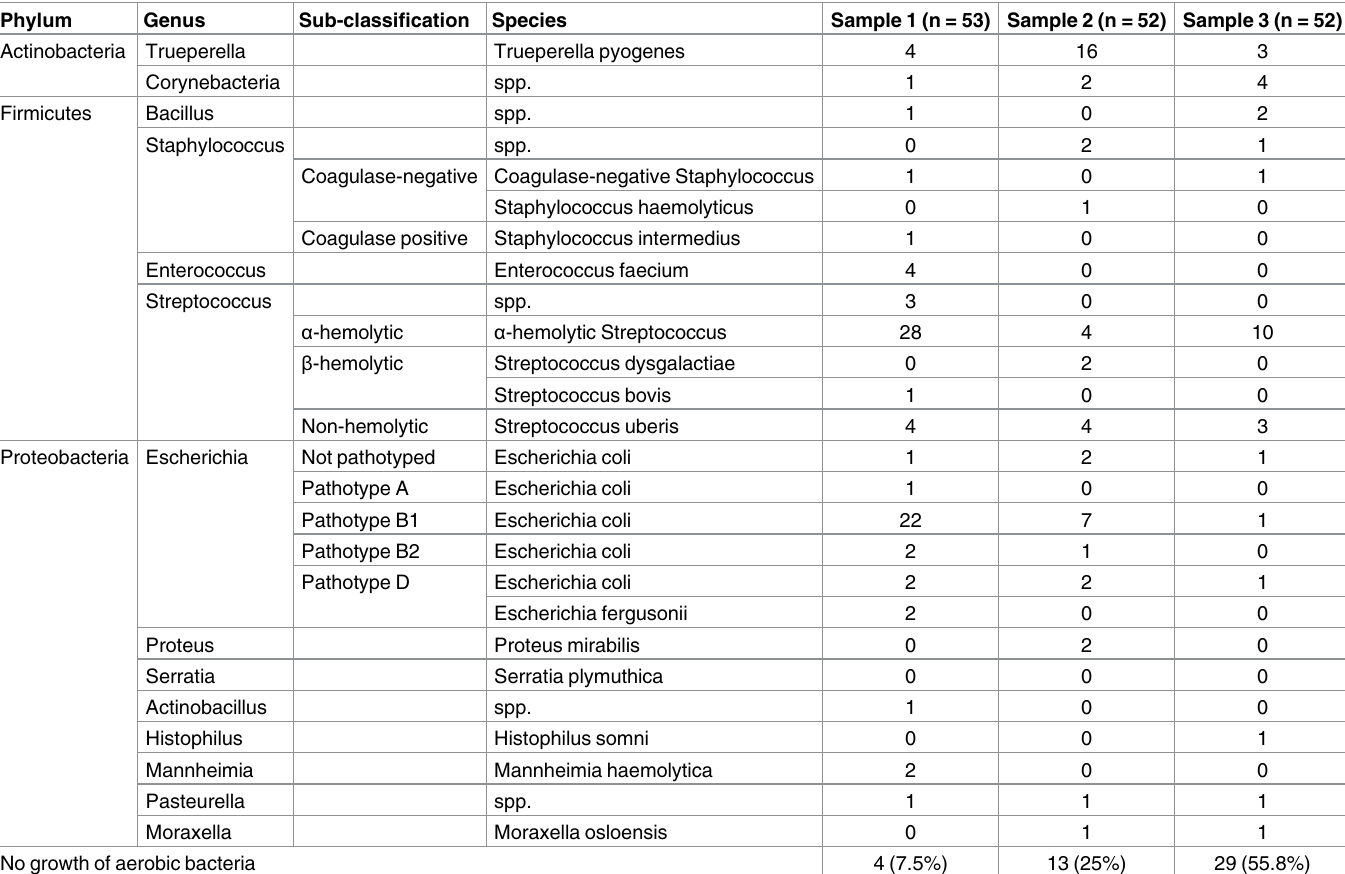
Table 1. Number of samples that cultured positive for each type of aerobic bacterial species isolated from uterine samples on the day of calving (sample 1), the day of follicular fluid aspiration ± 1 (sample 2), and on 35 ± 1 days postpartum (sample